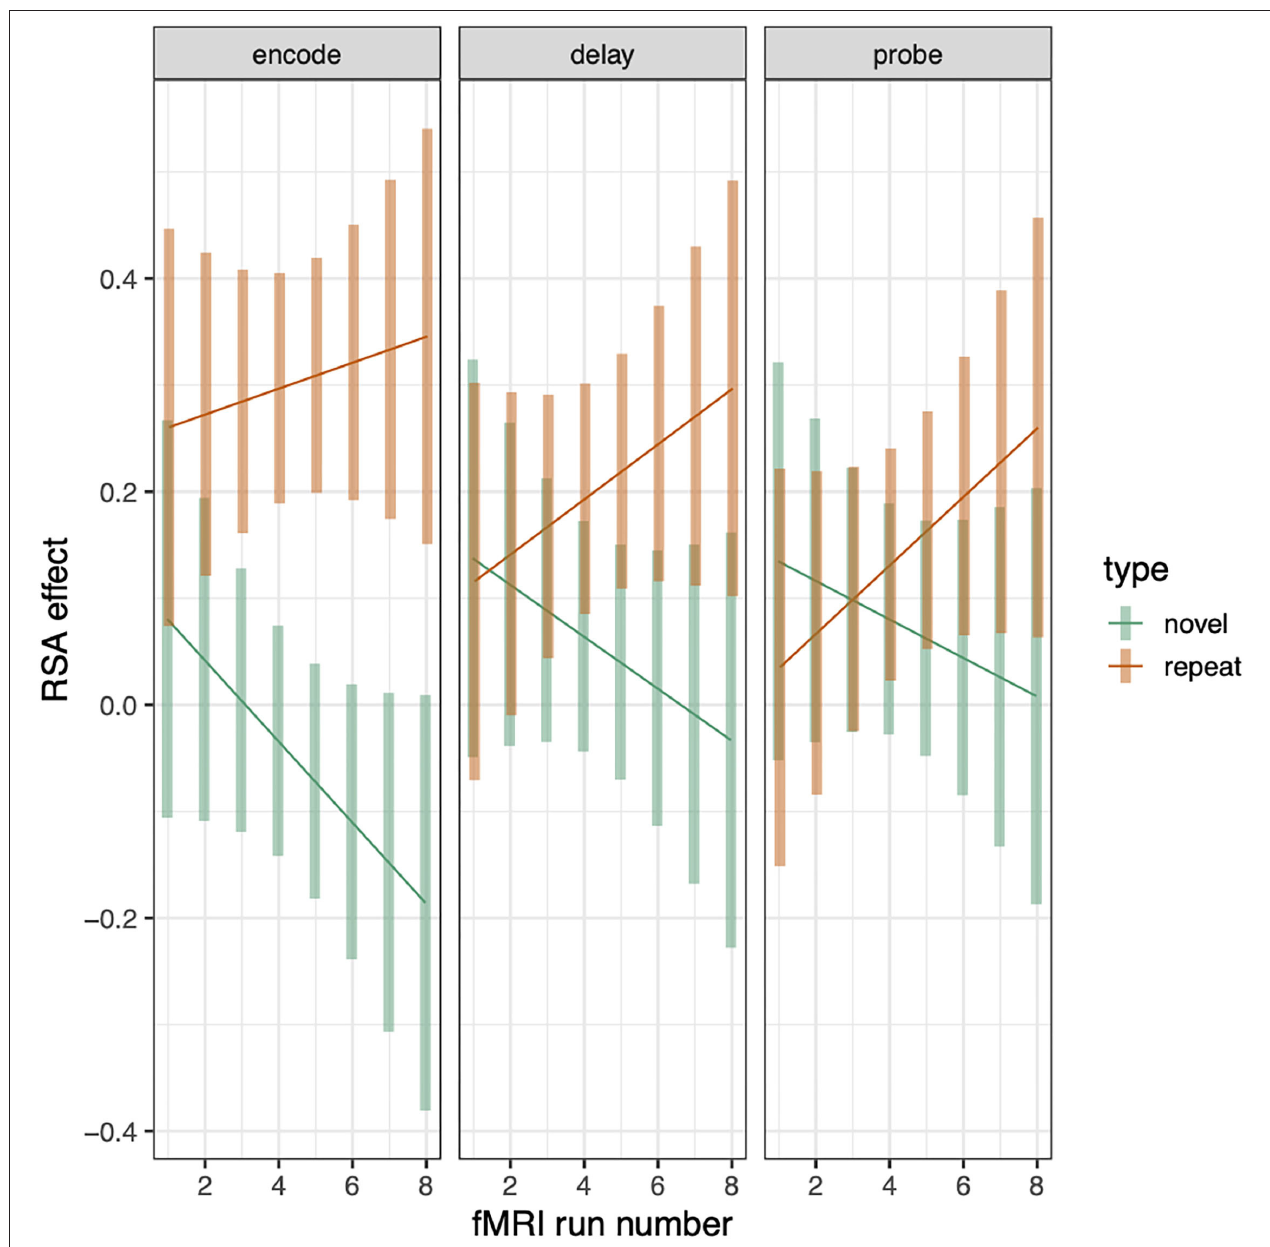
FIGURE 6 | RSA effect in Spt/PSL split by sequence type and plotted across run. Error bars are 95% confidence intervals.